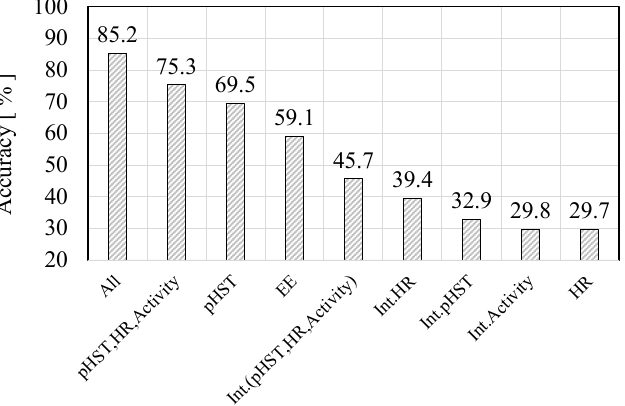
Figure 9. Dependency of feature selection on prevention accuracy.